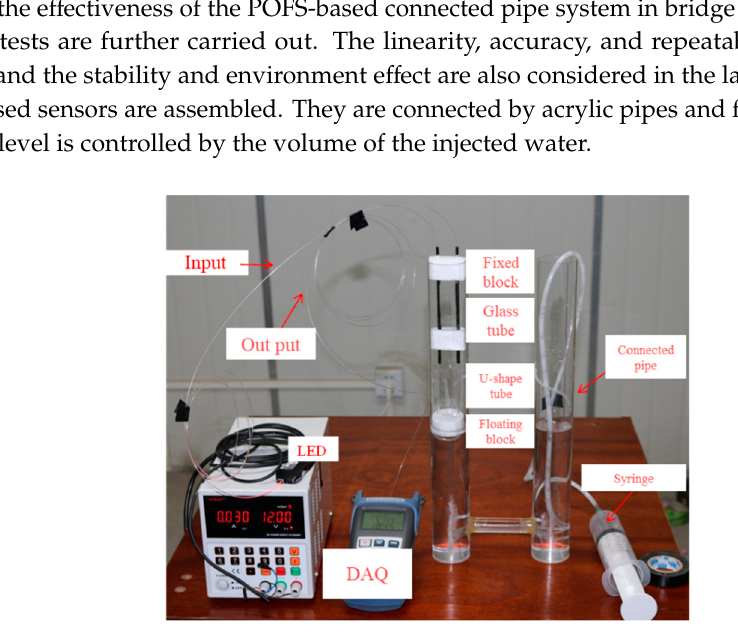
Figure 6. Experimental setup of a liquid level sensor. Note: DAQ = data acquisition; LED = light-emitting diode.